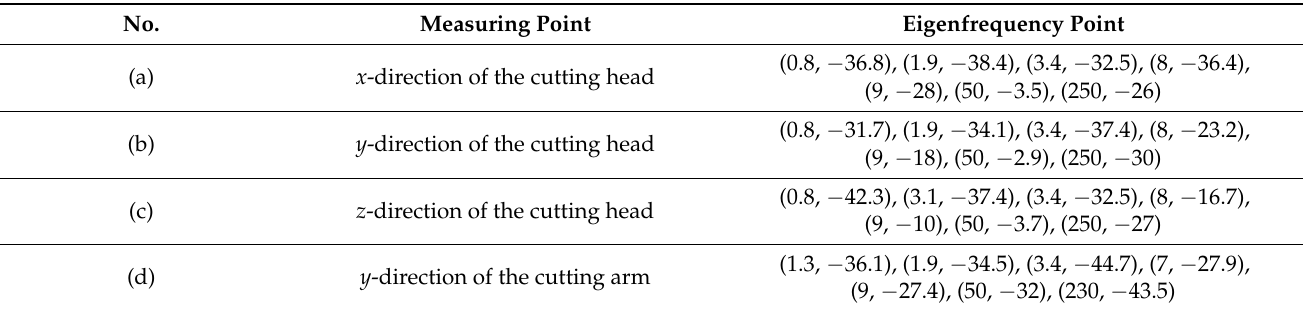
Table 3. Acceleration power spectrum eigenfrequencies of the cutting head in the horizontal cut- ting experiment.